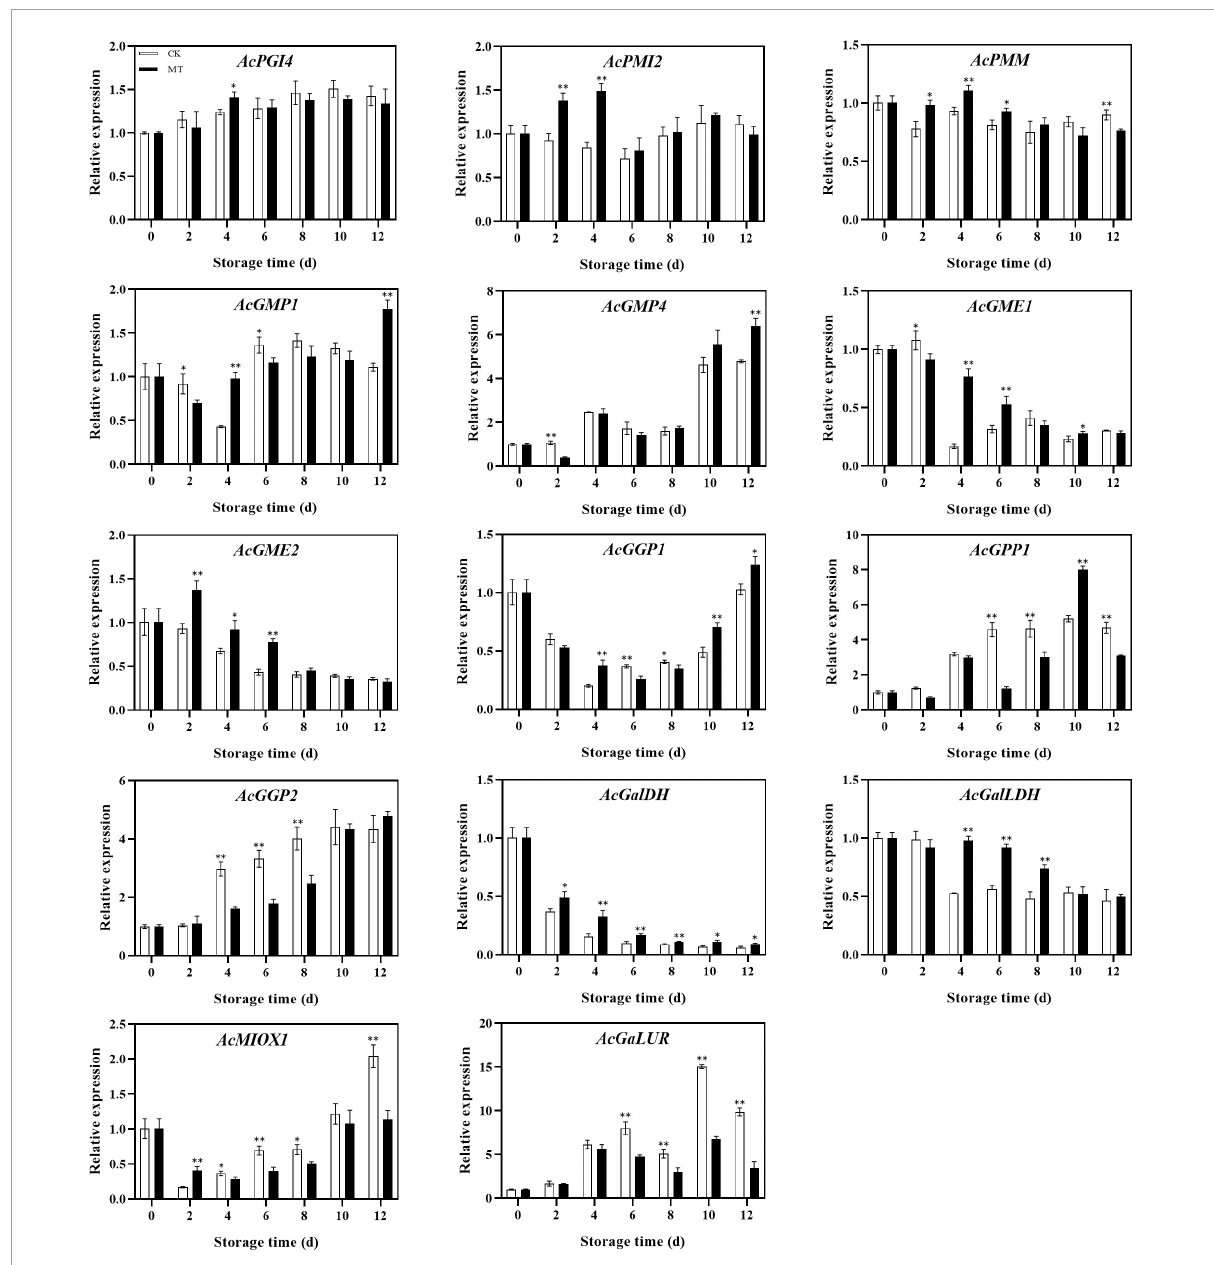
FIGURE4 Effects of melatonin (MT) treatment on expression levels of genes involved in ascorbic acid biosynthesis of ‘Jinyan’ kiwifruit. Data represent the means ± SE ( n = 3). Asterisks indicate significant differences between the control and MT treatments (* P < 0.05; ** P <